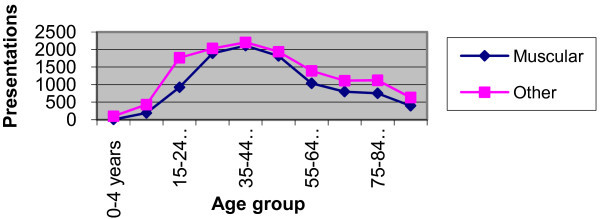
Presentations by Category type and Age.